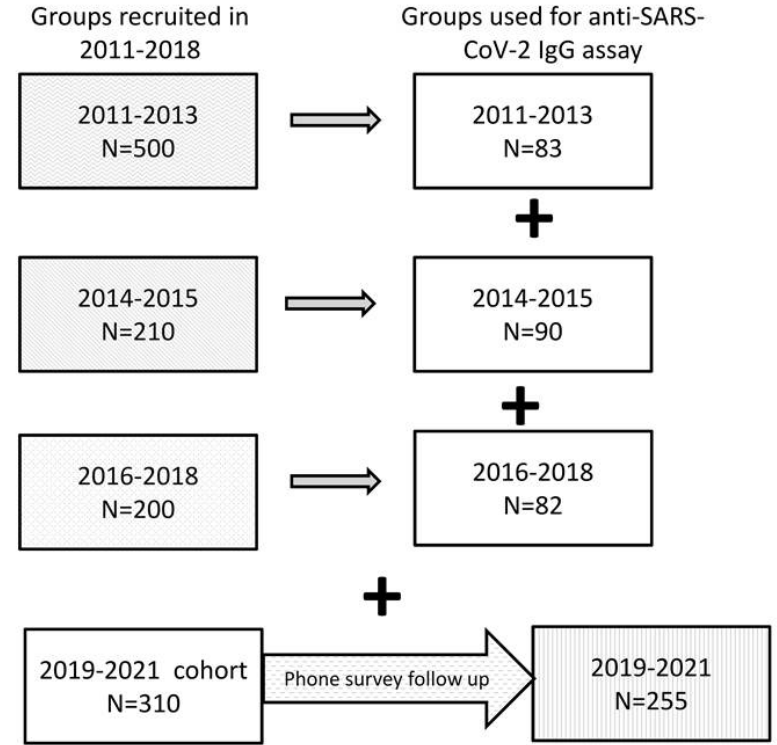
Figure 1. Protocol of the study. The present study was based on various cohorts previously recruited from 2011 to 2021 in the city of Moscow and Moscow Region. Subjects involved in various cardiovascular studies of the groups 2011–2013 and 2016–2018 represented patients with coronary artery disease, and apparently healthy individuals were included in the cohort study of microcirculation (groups 2014–2015 and 2019–2021). The groups were selected from the corresponding cohorts. The phone survey of the participants of cohort 2019–2021 was conducted in October 2021. The primary protocol for the 2019–2021 cohort was not aimed at investigating COVID-19. All participants were exposed to COVID-19